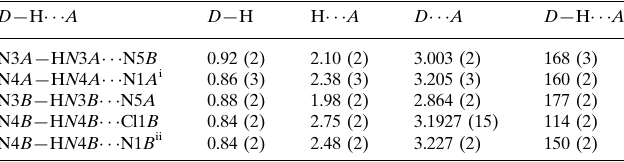
Hydrogen-bond geometry (A˚ , (cid:2)